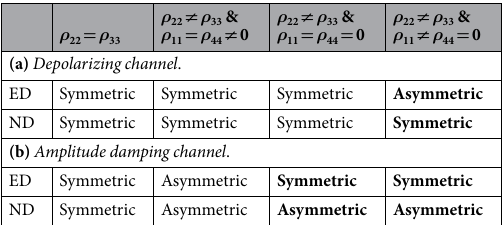
Table 1. Behavior of entanglement decay (ED) and decay of non-locality (ND) for different families of initial